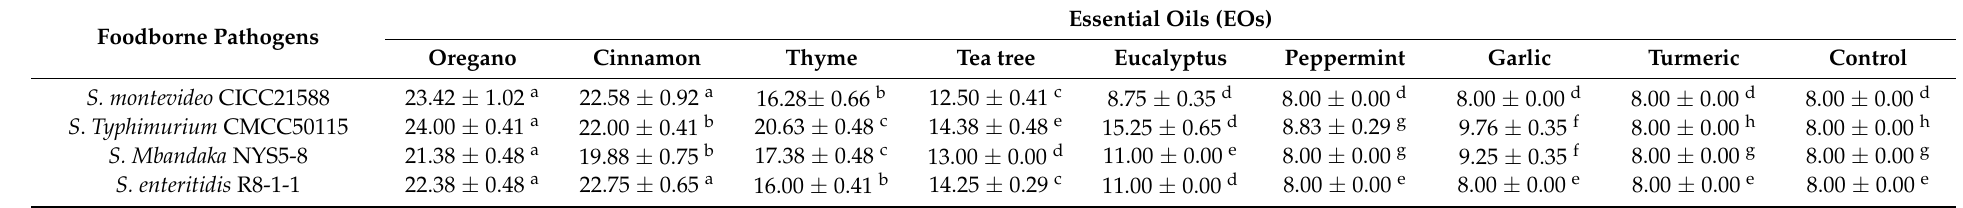
Table 2. Antimicrobial activity of EOs against 4 Salmonella strains using the oxford cup assay.